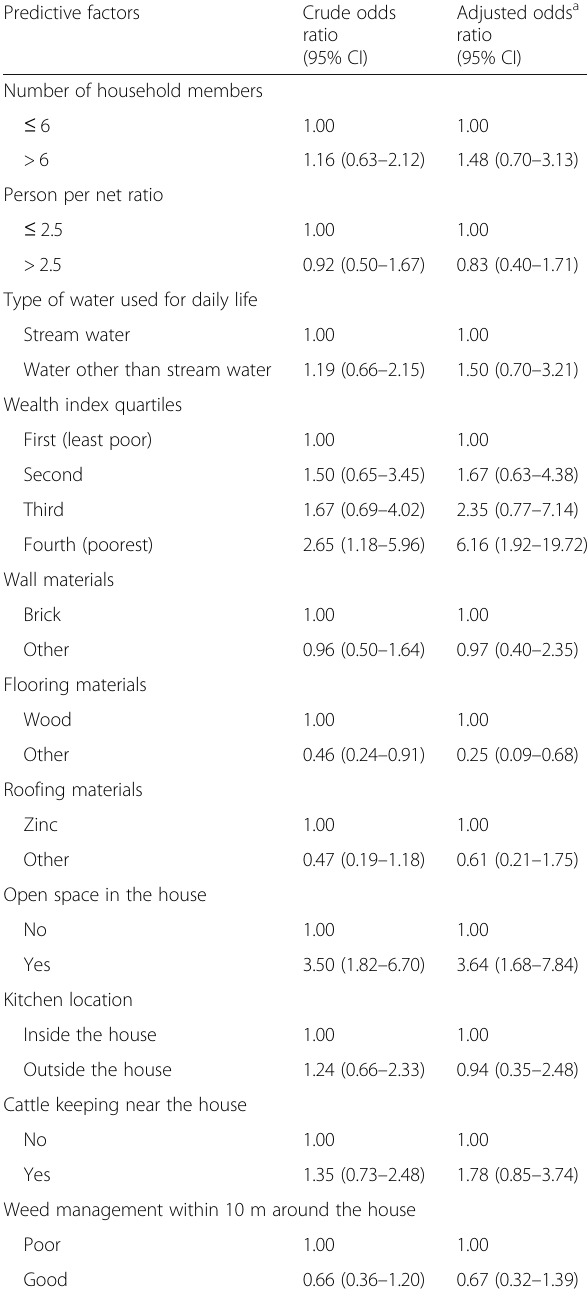
Table 5 Multivariate analysis of the associations between household characteristics and case-control status Predictive